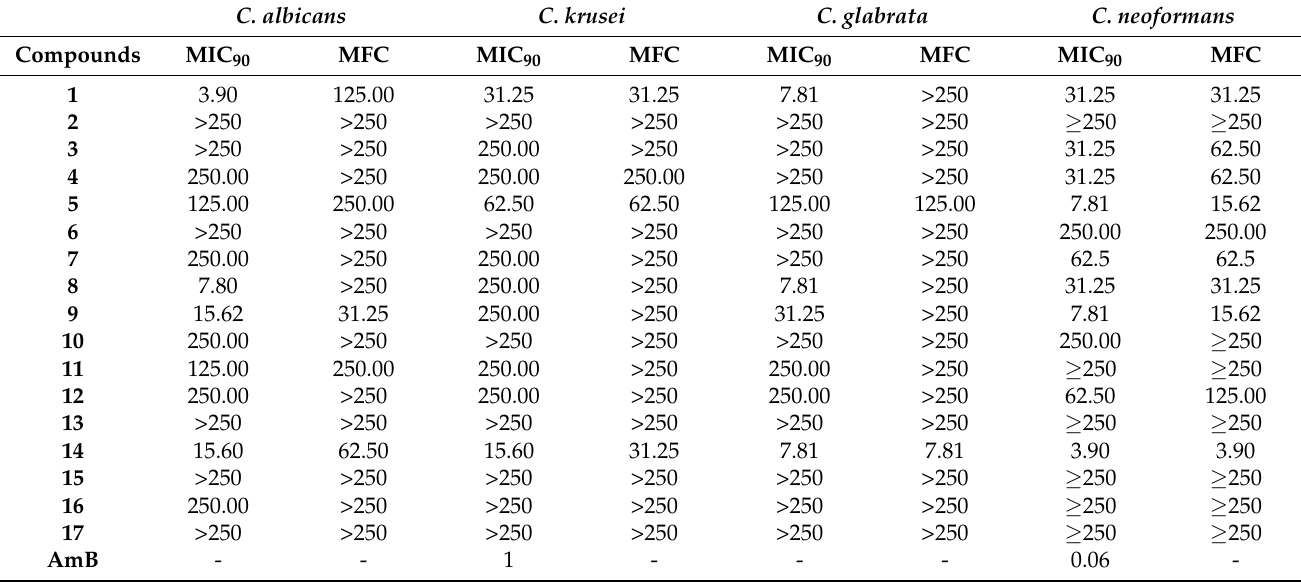
Table 1. Minimum inhibitory and fungicidal concentration values ( µ g/mL) of the 17 nitrofuran derivatives against C. albicans , C. krusei , C. glabrata, and Cryptococcus neoformans .